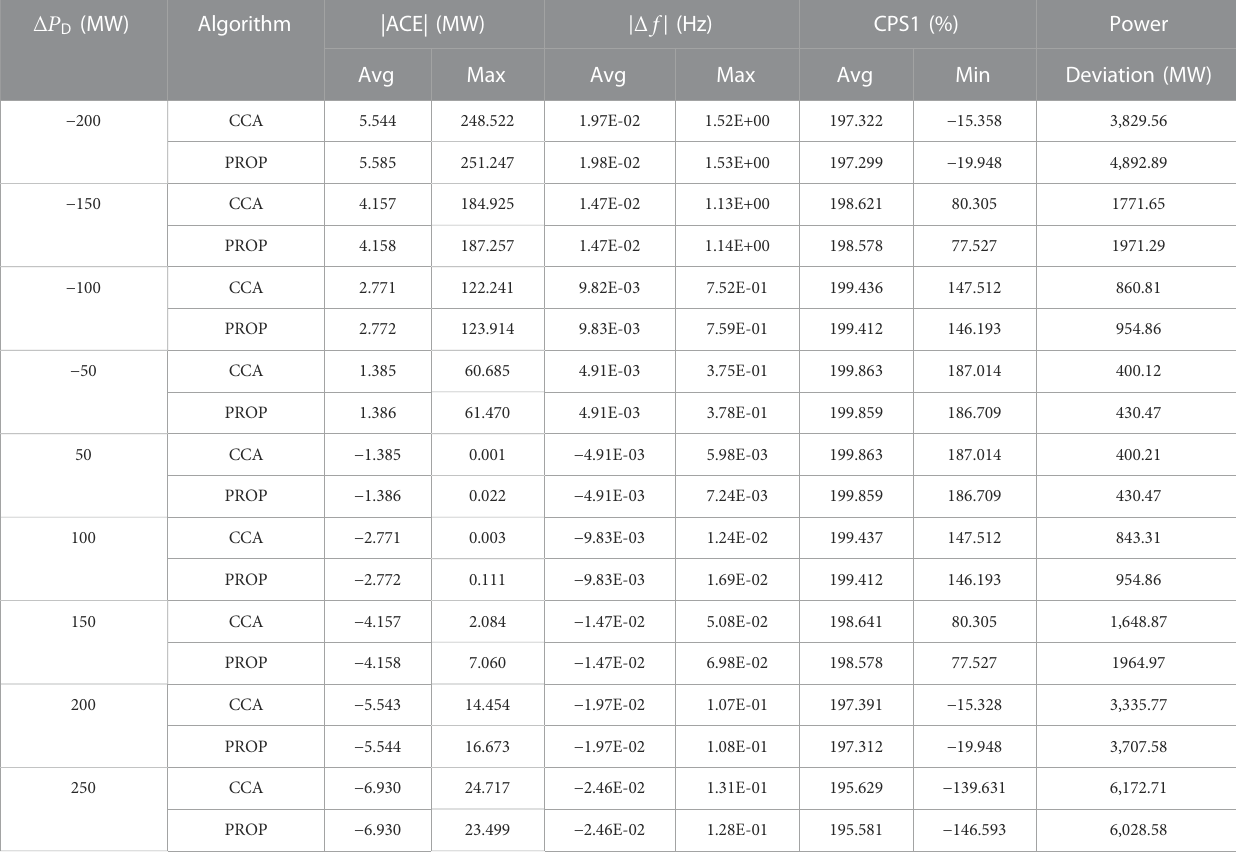
TABLE 4 Comparisons of dynamic optimization under different